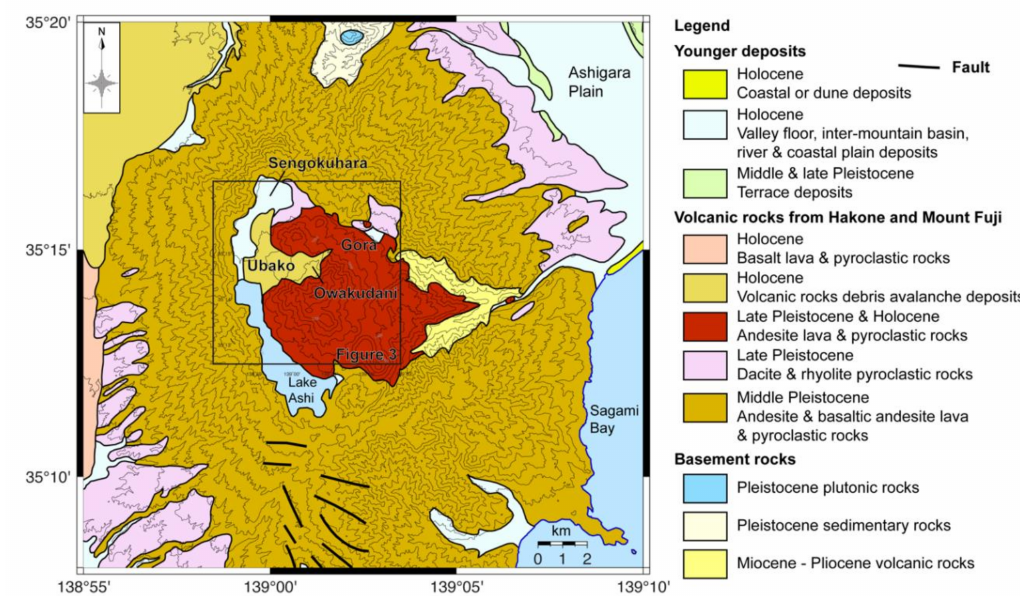
Figure 2. Geological map around Hakone Volcano (modified from the Seamless Geological map of Japan [6]). The original geological map was simplified based on ages and types of rocks. Contour lines in which intervals are 100 m were extracted from 10 m mesh height data released by the GSI. The area enclosed by the rectangle indicates the focus area of this study (Figure